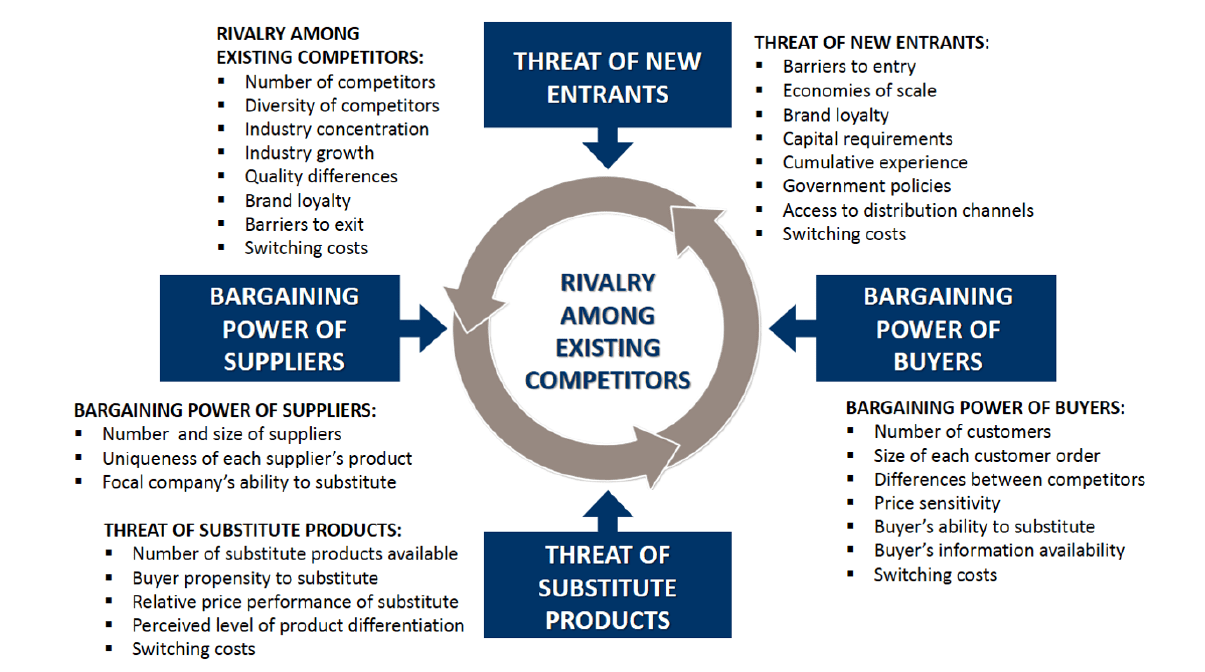
Figure 2: Porters Five Forces Theory; Source: Adapted from Porter